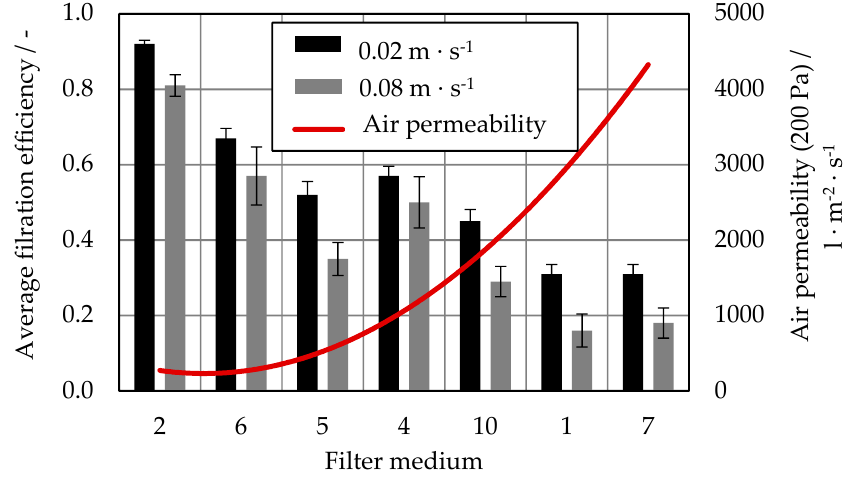
Figure 4. Averaged filtration efficiencies, depending on the flow velocity and filter medium, after conditioning the filter media in IPA-saturated air for 24 h, and the corresponding air permeability of the filter media.